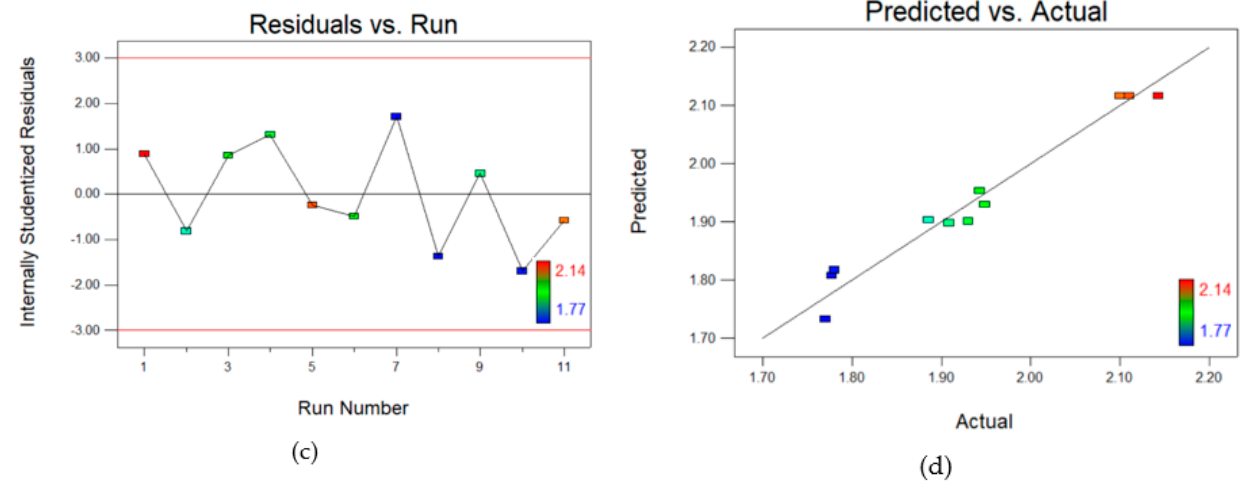
Figure 2. ( a–c ) Residual plots and ( d ) Predicted vs Actual plot for Central composite design (CCD) for pure water permeability.